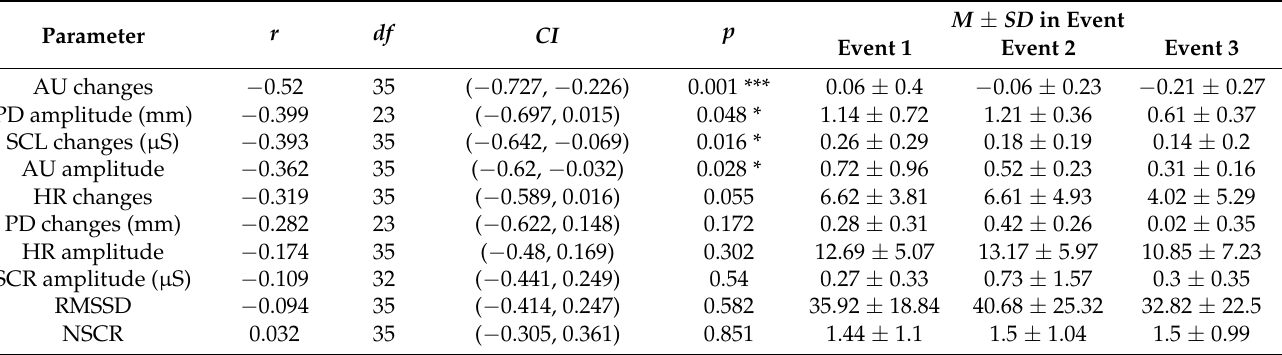
Table 2. Correlation of aggregated parameters and events sorted by correlation coefficient ( r